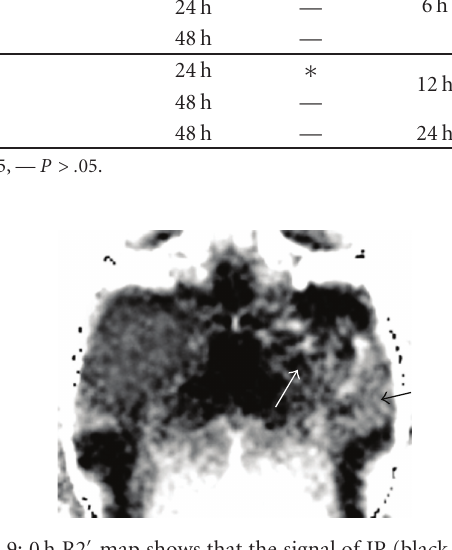
increased OEF. Thus, the infarcted core demonstrated con- secutive hypointensity in R2 (cid:2) images even after reperfusion. PET study has showed 50% increasement of OEF in IP